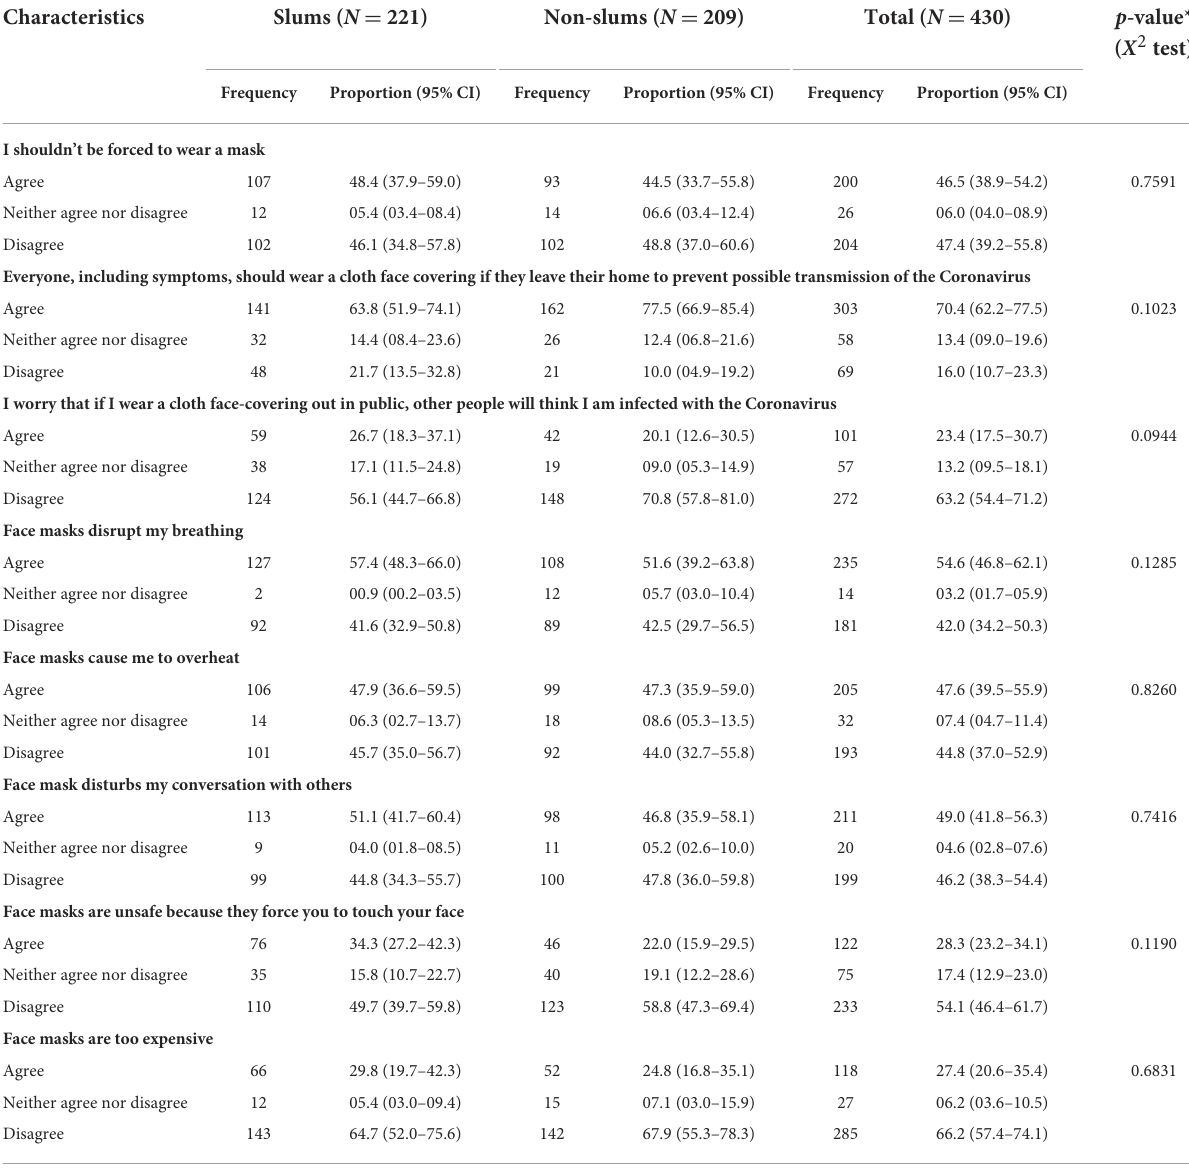
TABLE 3 Attitude toward mask use among the slum and non-slum population, Greater Chennai Corporation, India, March 2021 ( N = 430).